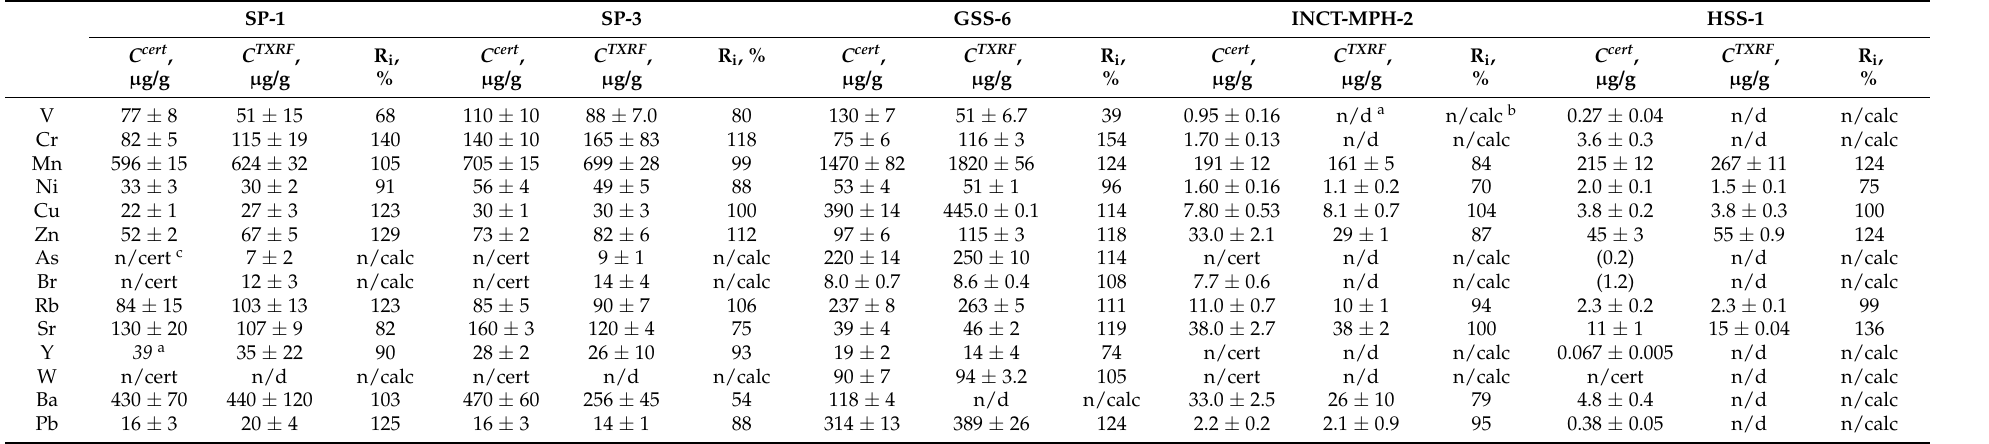
Table 6. The TXRF results validation with the CRMs of soils and